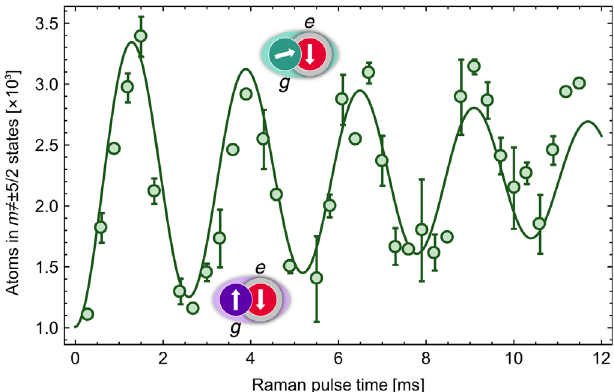
FIG. 6. Rabi oscillation on the bound-to-bound Raman transition peak performed at B ¼ 150 G and a 3D lattice depth s The Raman light coherently flips the ground-state nuclear-spin component of the molecules between the m ¼ þ 5 = 2 state and m ¼ þ 1 = 2 state, with a decay time constant of 12(3)